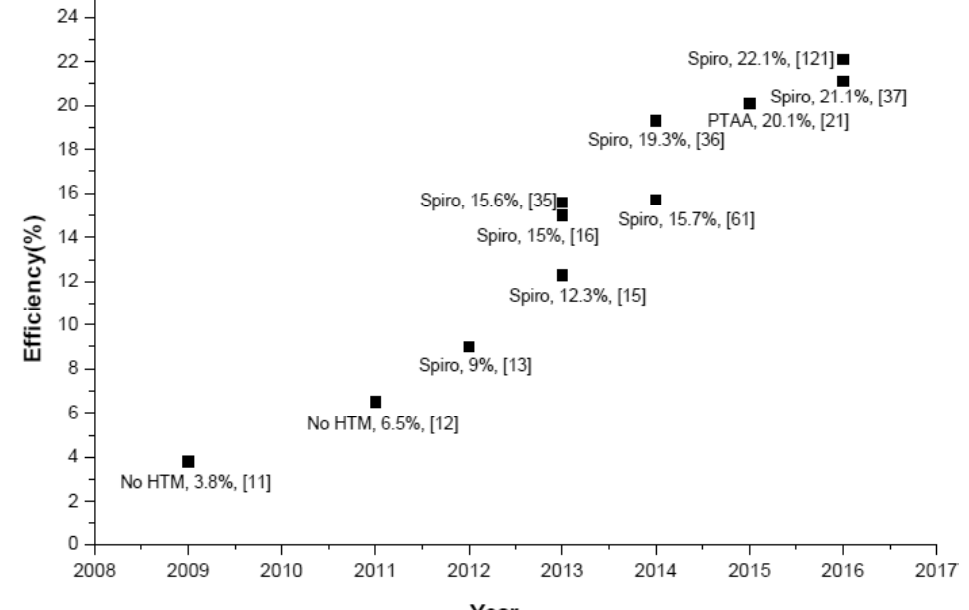
Fig. 2. Progress in efficiency of perovskite solar cell using organic/polymeric